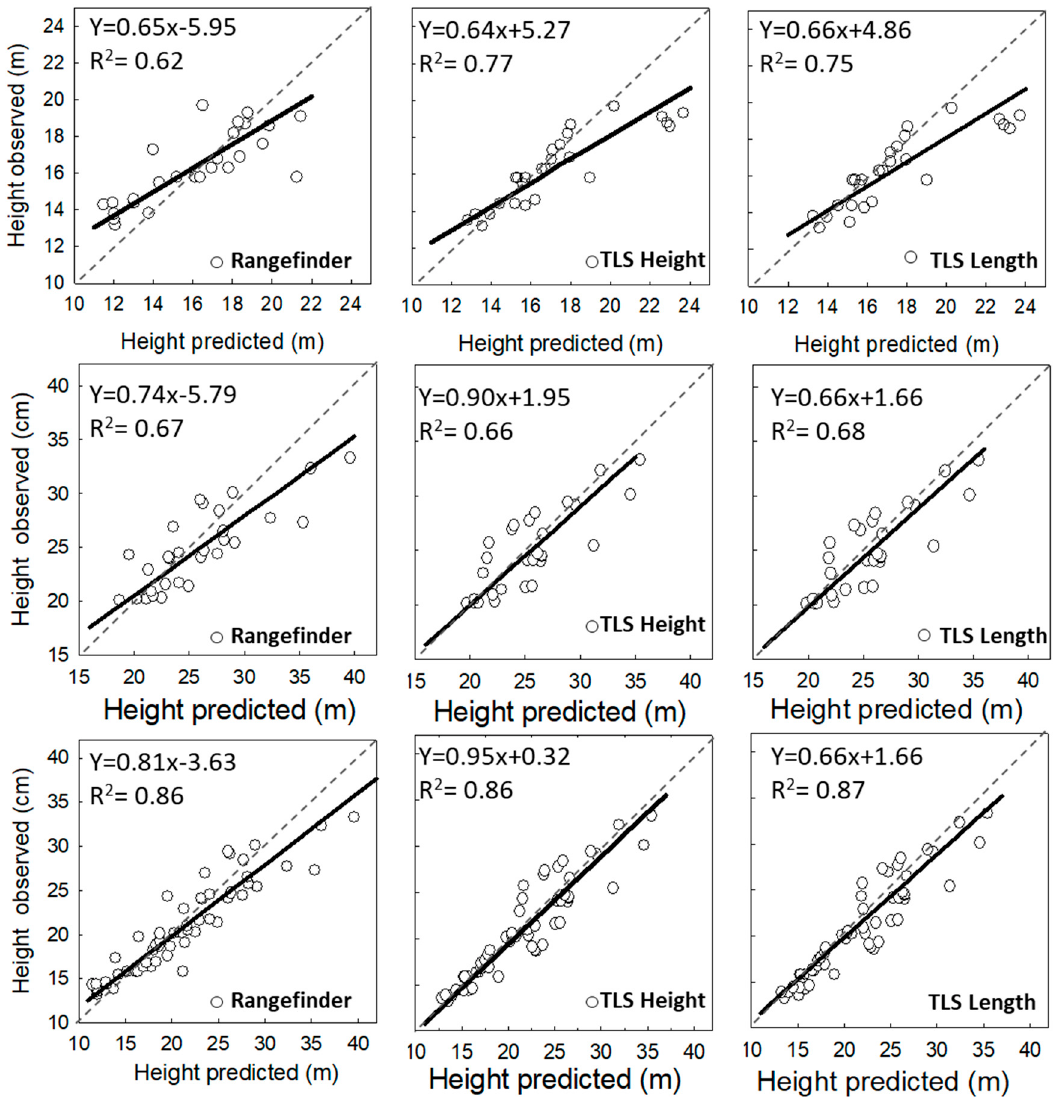
Figure 7. The observed (tape measured) tree height versus laser rangefinder, TLS Height , and TLS Length estimates for different tree size classes: 10 ≤ height < 20m (upper panel), 20 ≤ height ≤ 35m (middle panel), and all trees (lower panel): The solid curves represent the adjusted linear models, and the dashed lines represents the 1:1 lines (Y = X).